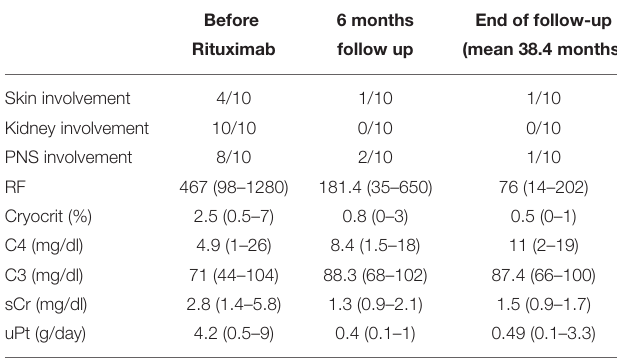
TABLE 2 | Clinical and at the time of Rituximab. TABLE 3 | Clinical and laboratory improvements at 6 months and at last follow up compared to baseline figures in 10 pts given at least 1 complete cycle of